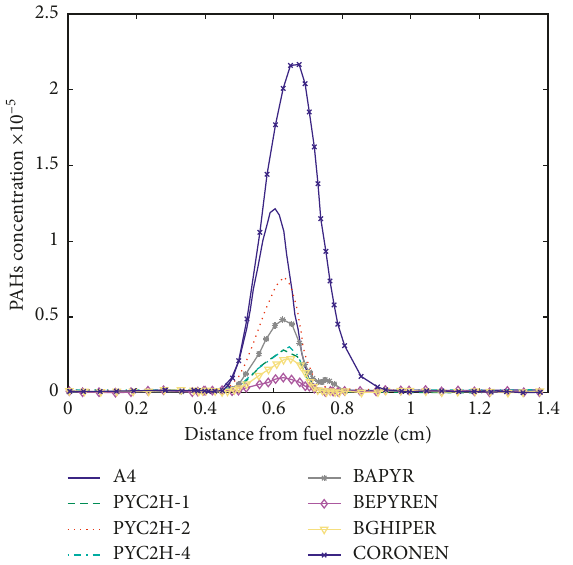
Figure 2: Simulated profiles of large PAHs by KM2 mechanism.